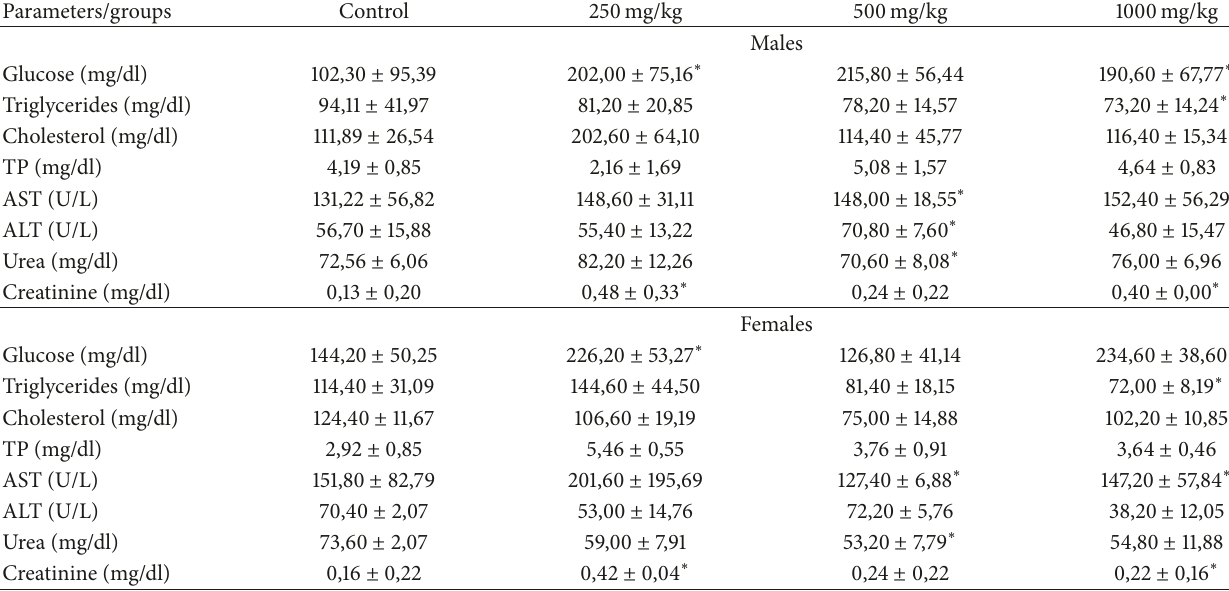
Table 1: Results of the biochemical dosages in the evaluation of acute toxicity of K. brasiliensis